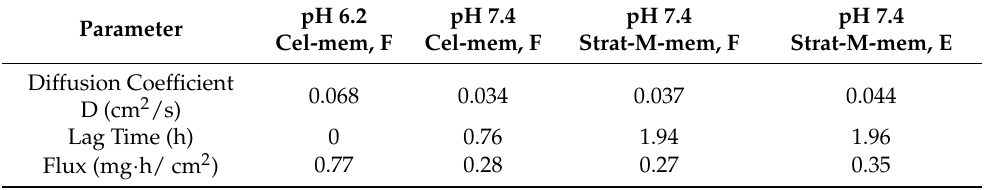
Figure 5. Figure 5. Membrane diffusion studies of FA. Cel-mem: Cellulose membrane, Cel+lec-mem: Cellulose membrane with soy lecithin, Strat-M-mem: Strat-M ® membrane, F: free compound, and E: encapsulated compound. encapsulated compound. Table 2. Permeability Table 2. Permeability parameters.